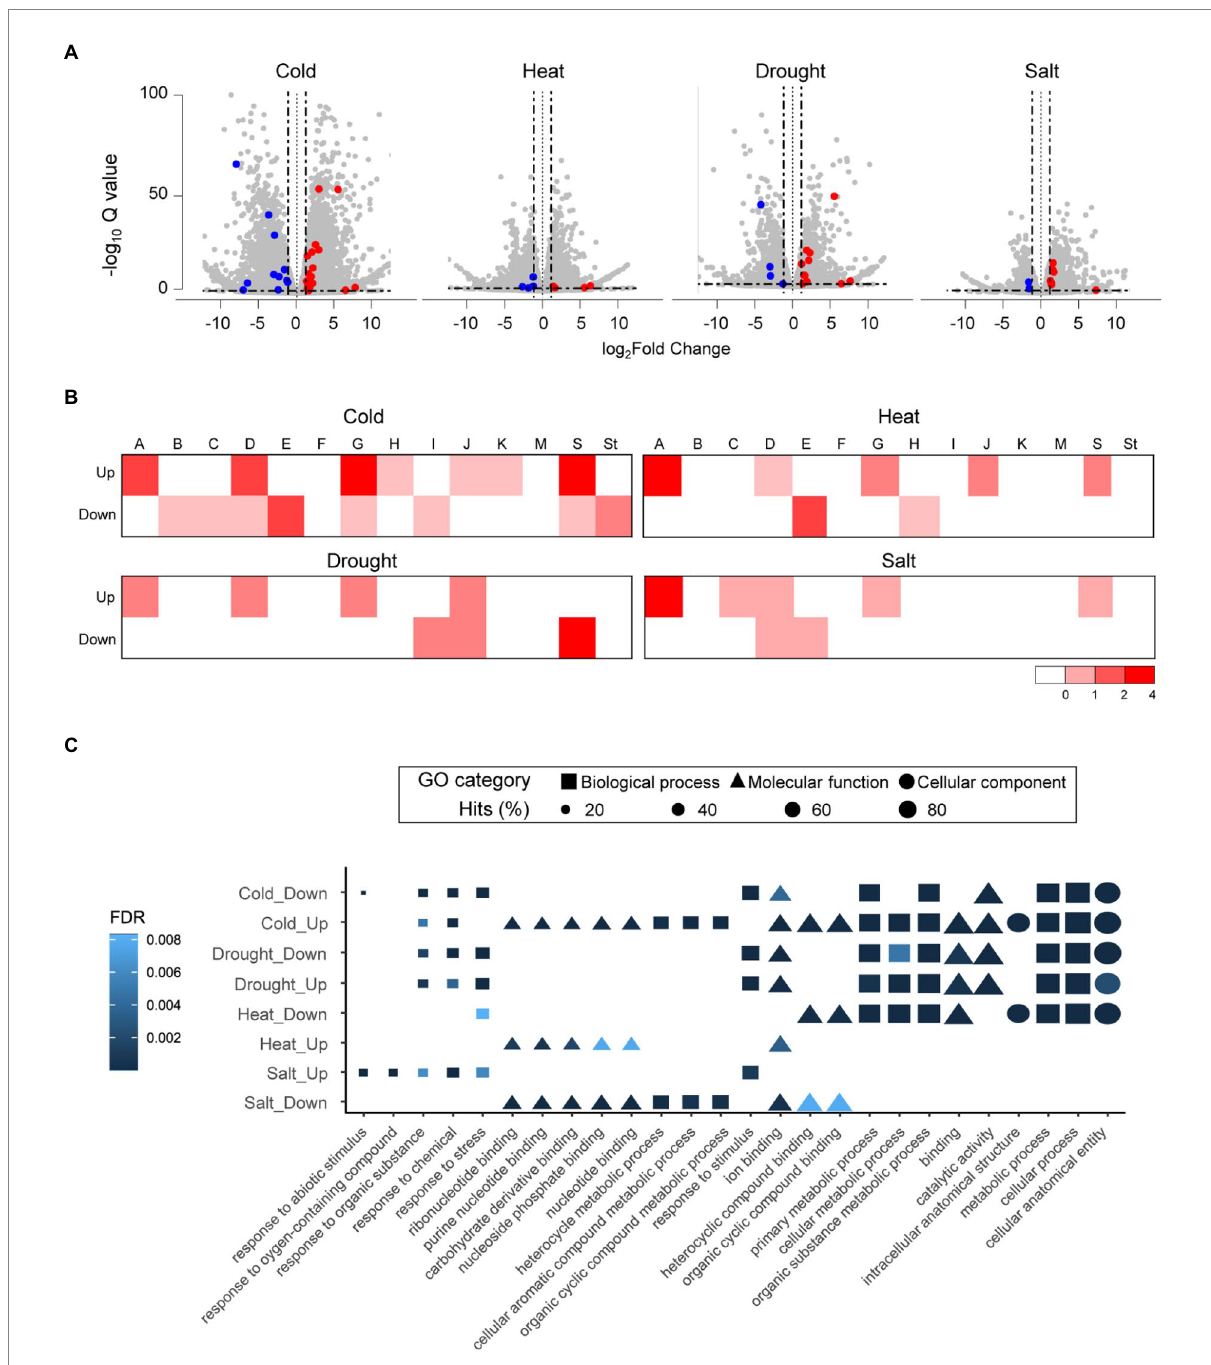
FIGURE 5 Expression analyses and functional predictions of differentially expressed genes under different abiotic stresses in tomato ( Solanum lycopersicum ). (A) Volcano plot for tomato DEGs under different abiotic stresses. Scattered gray dots represent whole genes in tomato. Red and blue dots depict upregulated and downregulated bZIP DEGs based on 1-fold expression difference (represented by two black vertical lines). (B) Number of bZIP DEGs in each subgroup is displayed in a heatmap. Heatmap values on the bottom right side indicate the number of bZIP DEGs in each subgroup. (C) Dot plots depict the top five GO enrichment results for each group including bZIP genes. Shapes represent the GO categories; shape sizes represent the GO term